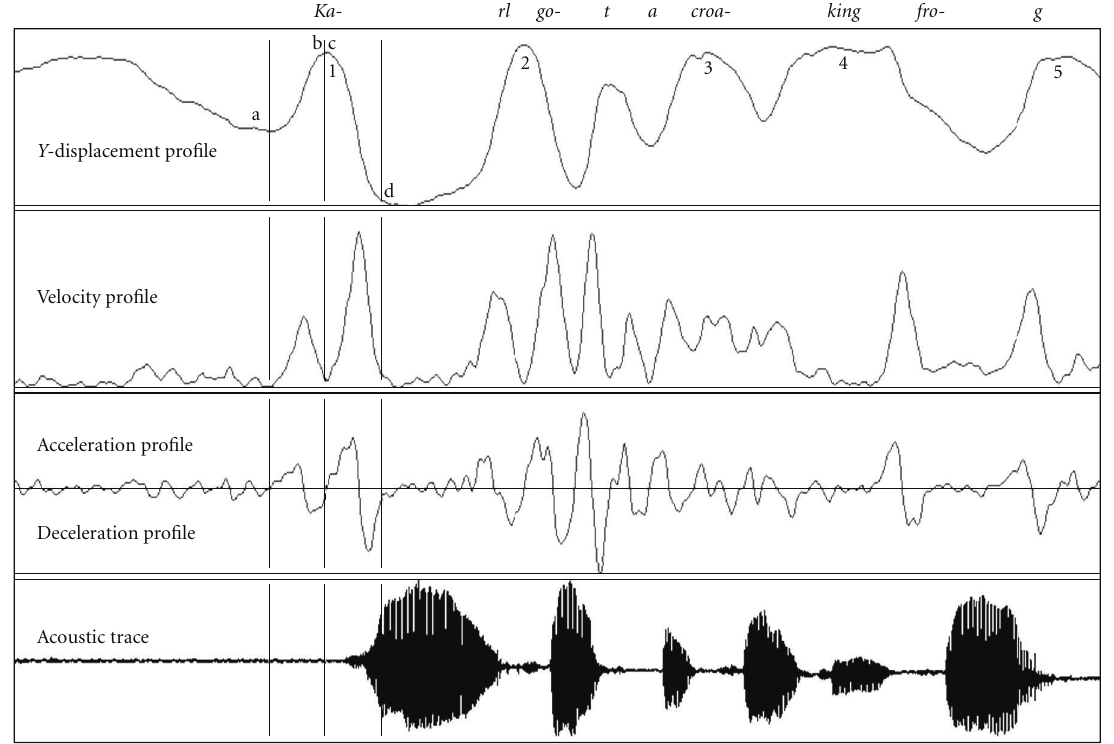
Figure 1: Example of tongue back movement in a participant with PD during the production of Karl got a croaking frog. 1–5: peaks for analysis, a: start of approach, b: end of approach, c: start of release, d: end of release. Duration of approach phase [(b-a) × 5], and release phase [(d-c) × 5], given a sampling rate of